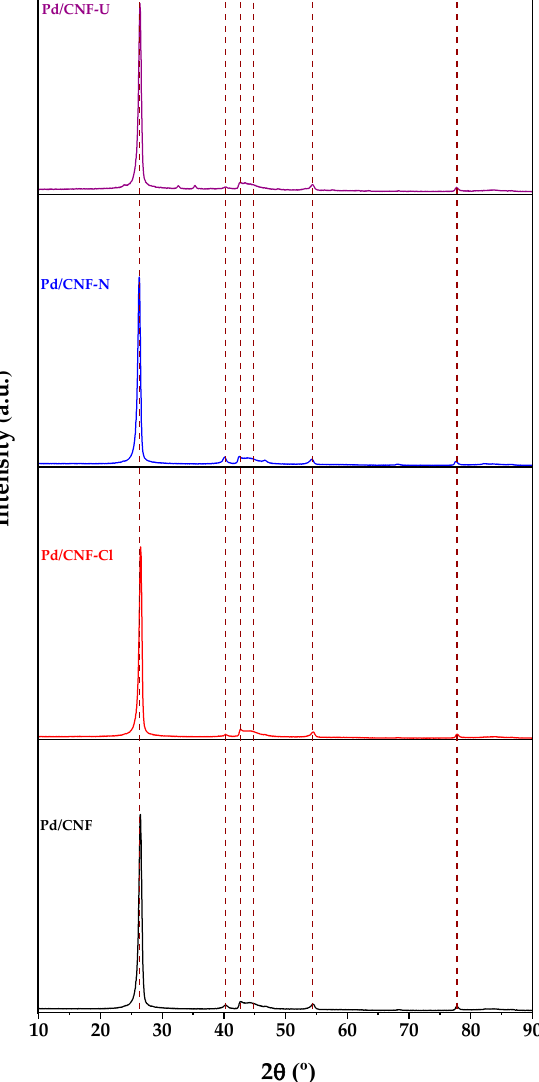
Figure 2. XRD patterns of the catalysts (I: C(002); II: Pd(111); III: C(100); IV: C(101); V: C(004); VI: